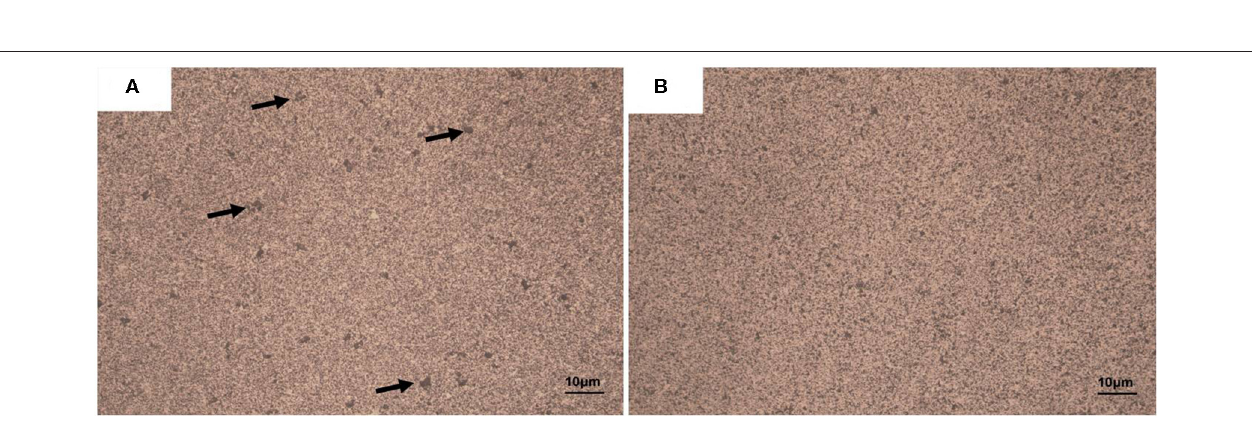
FIGURE 4 | The photomicrographs of the alloys with different Mo 2 C addition amount: (A) 0% Mo 2 C; (B) 6.0% Mo 2 C.